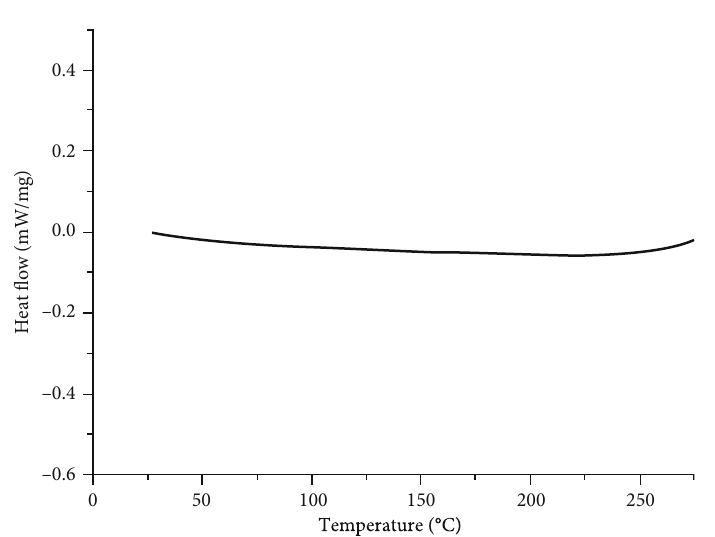
Figure 2: DSC curve of cured